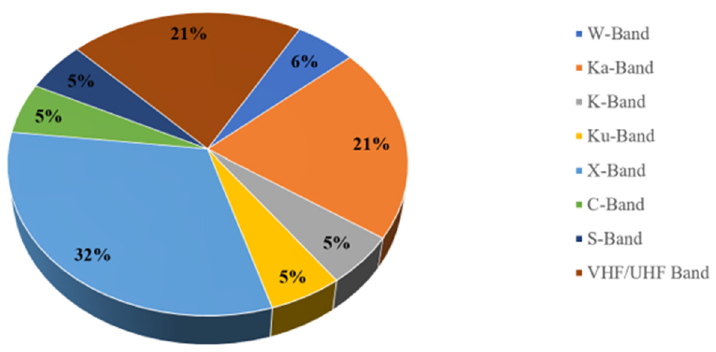
Figure 8. Operating frequency bands used in antenna arrays.